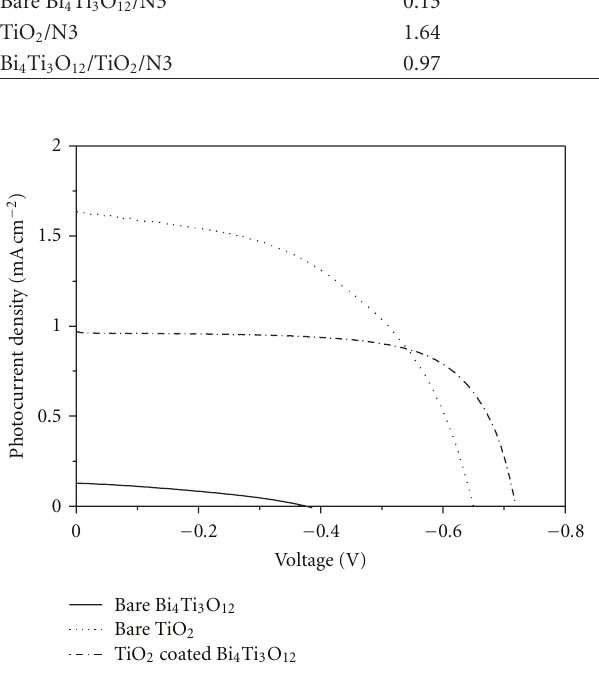
Figure 5: J - V characteristics of bare (curve a) and 5at % TiO 2 - modified Bi 4 Ti 3 O 12 (curve b) thin films. Figure 6: Dark current characteristics of bare (curve a) and 5 at % TiO 2 -modified Bi 4 Ti 3 O 12 (curve b) thin